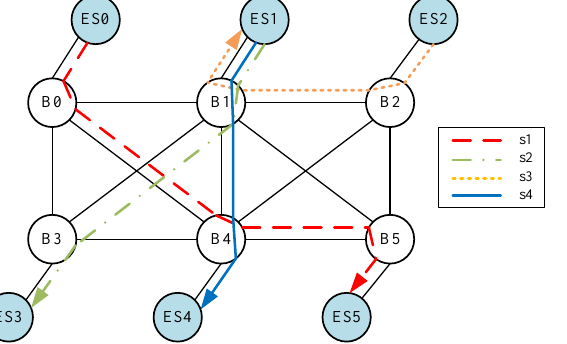
Figure 2. Example Time-Sensitive Network (TSN) topology model including 6 End Systems (ESs), which exchange 4 streams via 6 switches.